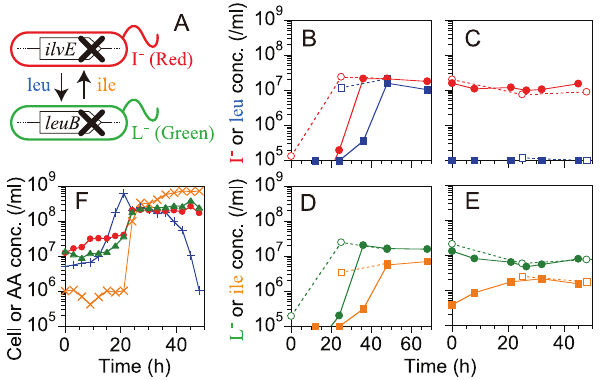
Figure 1. Basic design of the model system and cell growth during synthetic mutualism. (A) Schematic diagram of the synthetic mutualism. Two auxotrophs of E. coli , strains I – and L – , supply amino acids to each other and potentially establish mutualism, as described in the text. (B–E) Cell growth and nutrient release in the monocultures. The concentration of Leu or Ile is indicated as the density of L – or I – cells which can be produced by the amount of Leu or Ile, respectively. When the amino acid concentration was not detected (under the detection limit 10 5 /ml), we plotted it at 10 5 /ml. (B and C) The time course of the concentration of Leu (blue square) and I – cells (red circle) in monoculture. (B) 10 3 /ml (closed symbol) or 10 5 /ml (open symbol) I – cells were inoculated into minimal media along with 10 m M of Ile. 10 m M of Ile supports the generation of about 10 7 /ml I – cells. (C) 10 7 /ml I – cells were inoculated into minimal media without the addition of Ile. Closed and open symbols represent two independent experiments. (D and E) The time course of Ile (orange square) and L – cells (green circle). (D) 10 3 /ml (closed symbol) or 10 5 /ml (open symbol) of L – cells were inoculated into minimal media along with 10 m M of Leu. 10 m M of Leu was the amount required for the growth of about 10 7 /ml of L – cells. (E) 10 7 /ml of L – cells were inoculated into minimal media without the addition of Leu. Closed and open symbols represent replicates of two individual cultures. (F) The time course of the concentration of amino acids and the cells in coculture: I – (red N ), L – (green m ), Ile (orange 6 ), Leu (blue + ). 10 7 /ml of both I – and L – cells were inoculated into minimal media without the addition of any amino acids.